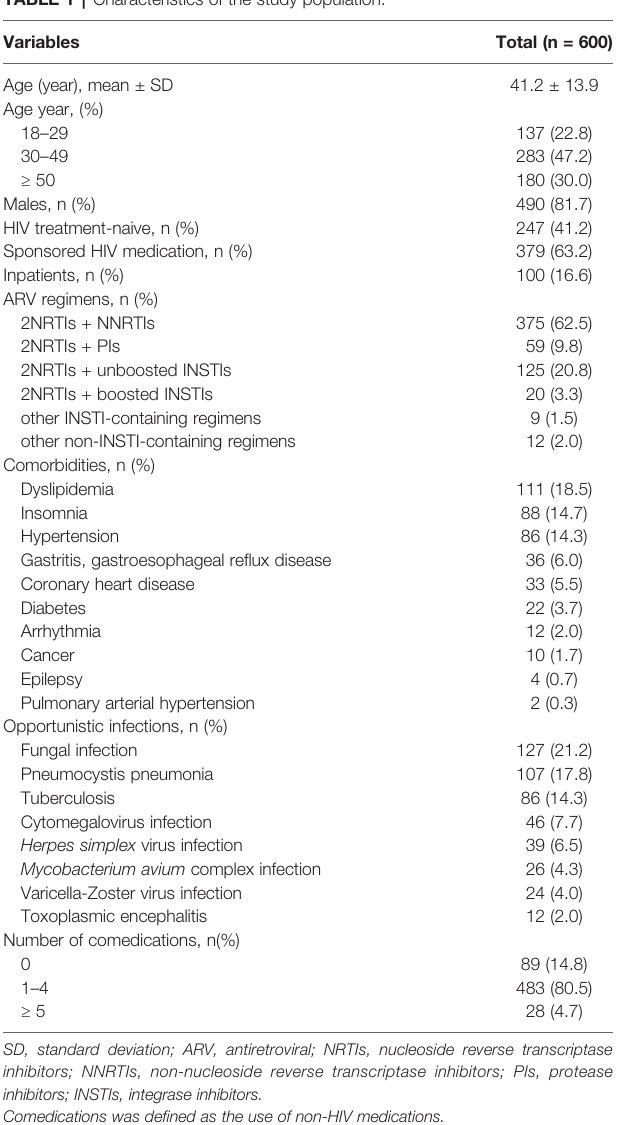
TABLE 1 | Characteristics of the study population.